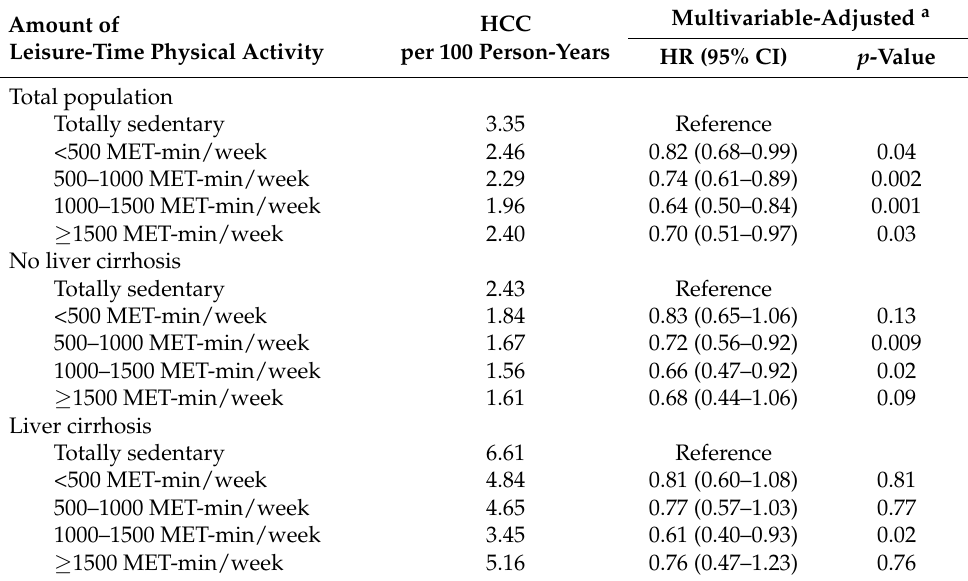
Table 2. Leisure-time physical activity and the risk of HCC development stratified by the presence of liver